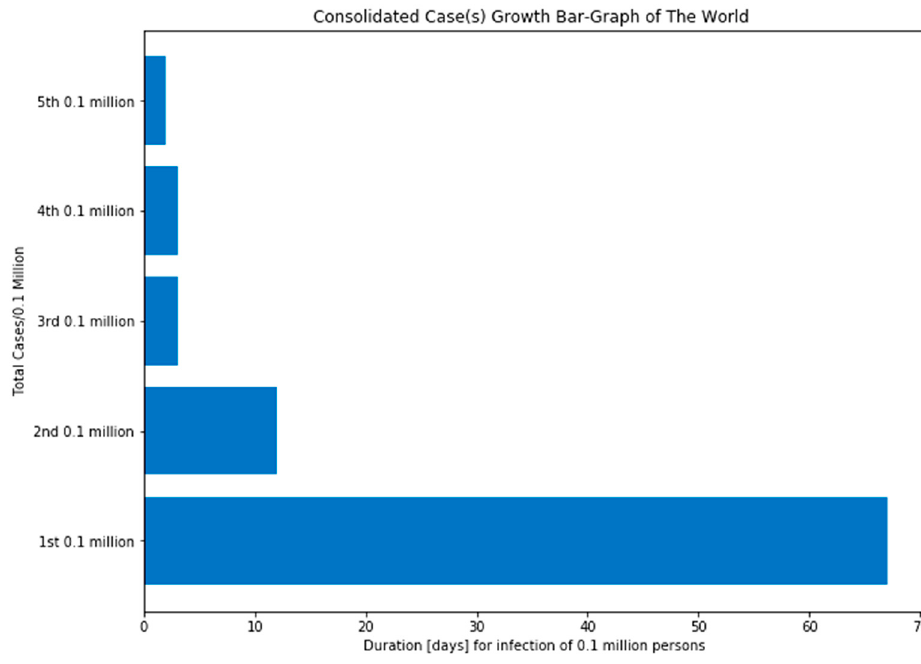
Figure 2. Consolidated case(s) growth of the “world”.